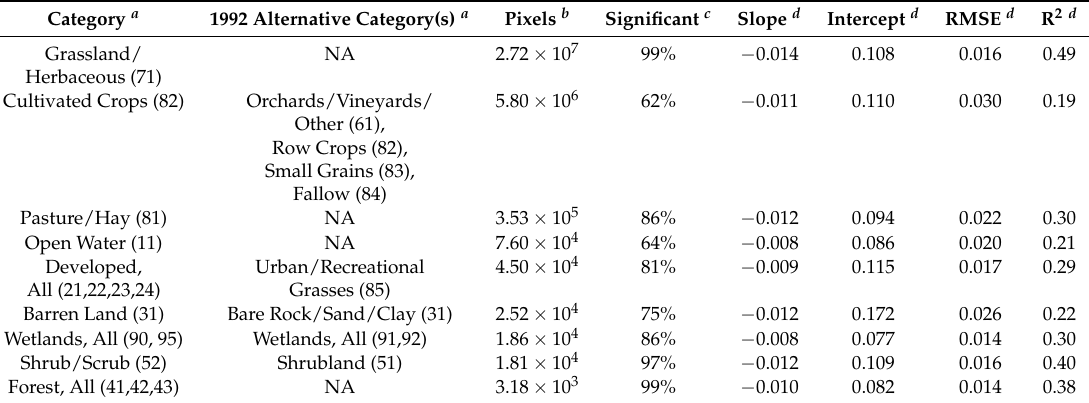
Table 2. Summary of NLCD